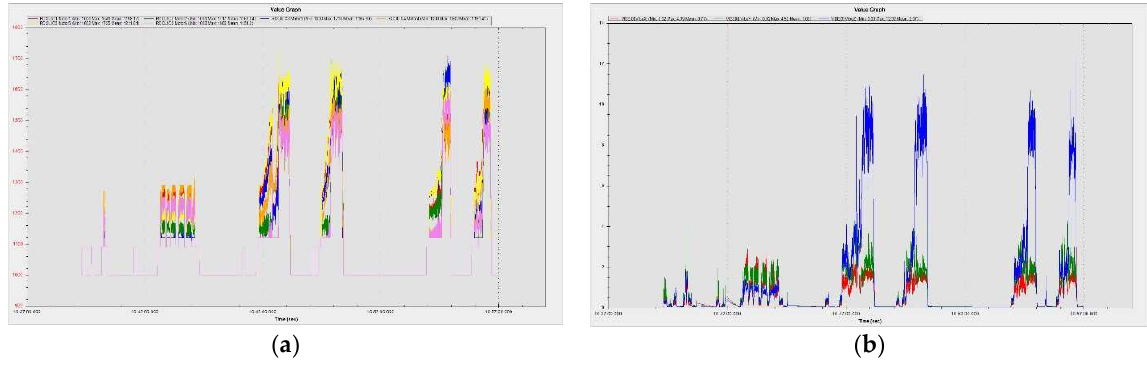
Figure 29. Results processed with the online platforms. ( a ) Engines response to the lift command; ( b ) Accelerometer (0) vibration recordings.